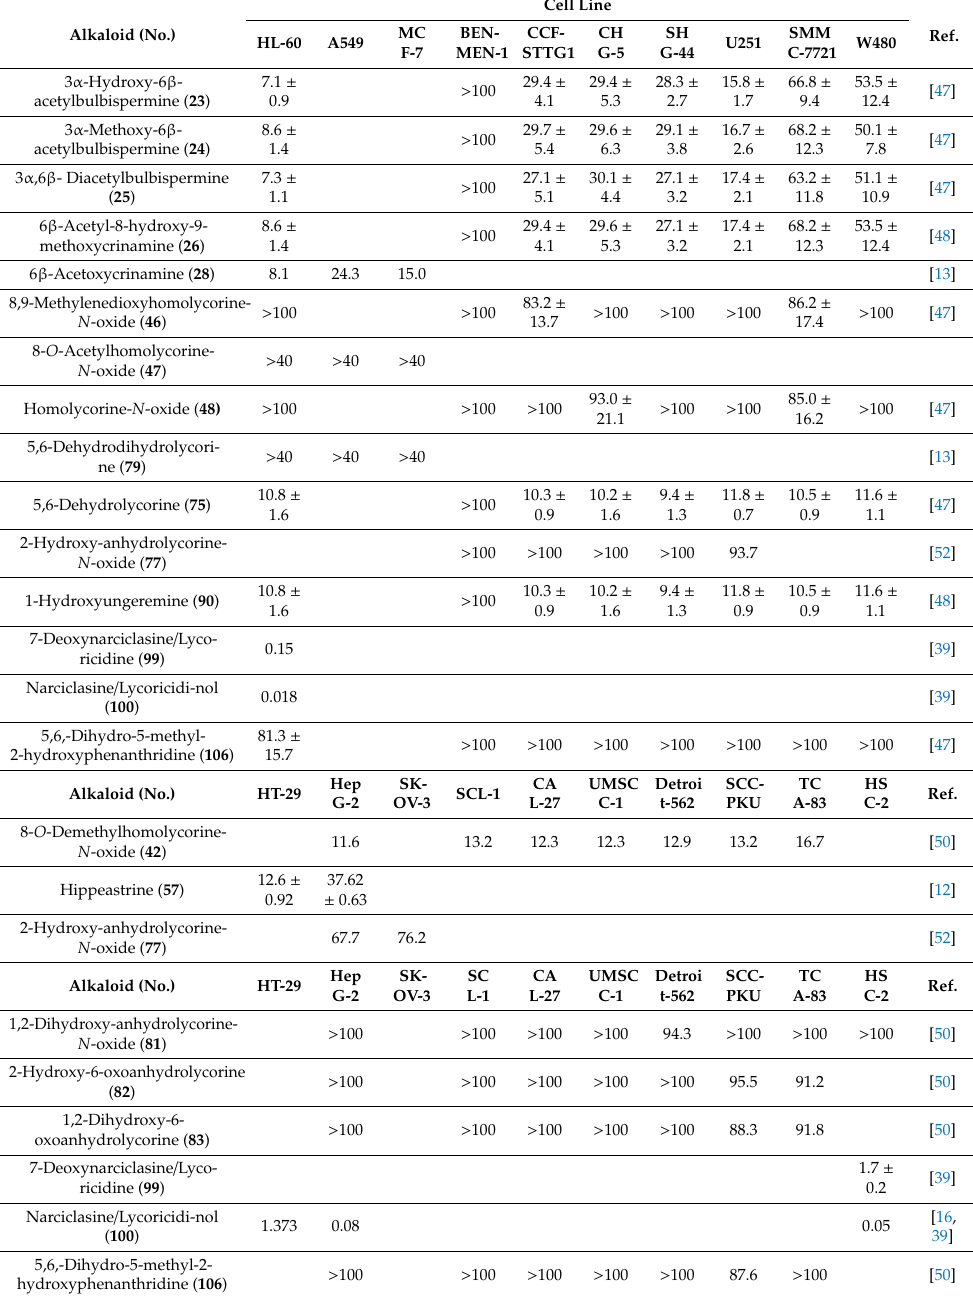
Table 2. Impact of Amaryllidaceae alkaloids (AA) isolated from Lycoris plants on proliferation of cancer and non-cancer cells using in vitro assays. Results are expressed as IC 50 values in µ M, unless otherwise stated.